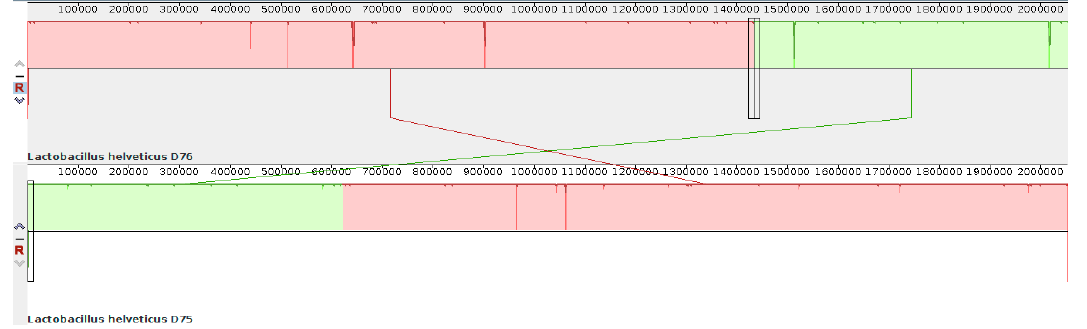
Figure 4. Location of genomic blocks in the genomes of L. helveticus D75 and D76 aligned with each other.